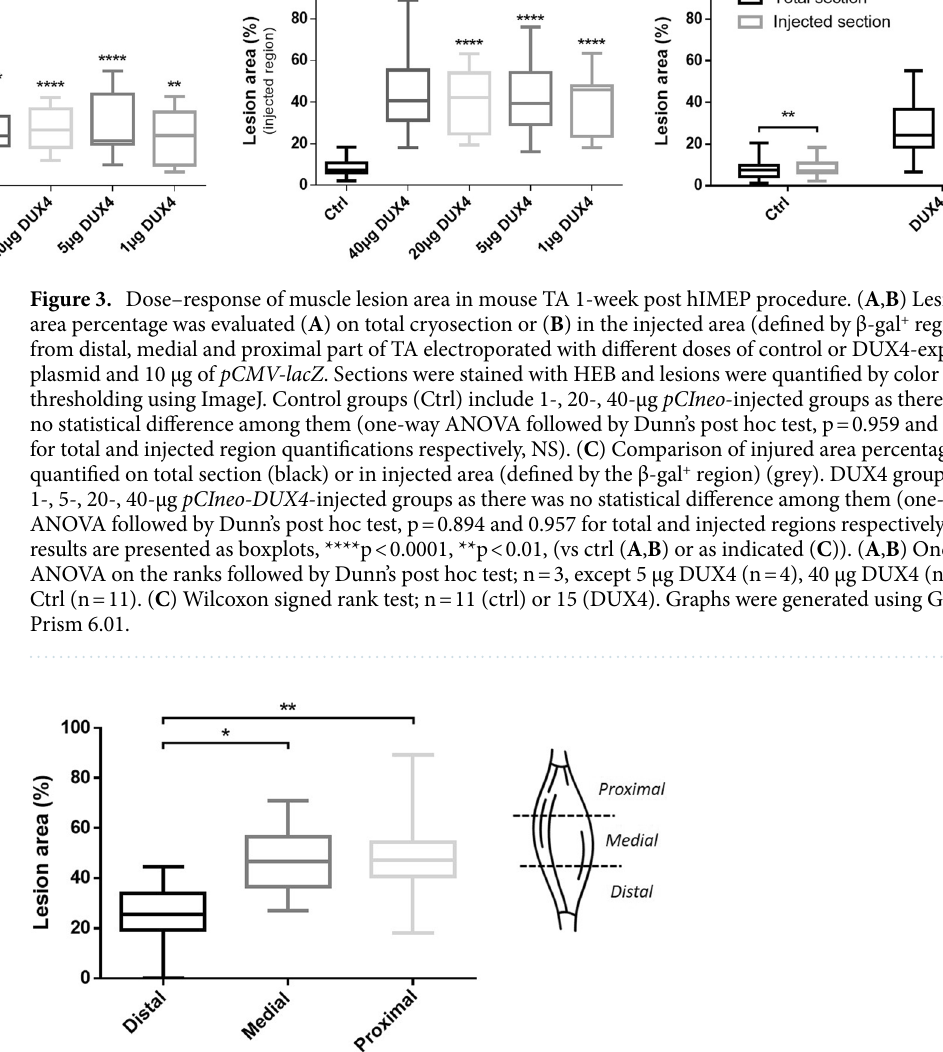
Figure 4. Lesion distribution through TA regions. Mouse TAs were electroporated with different doses of pCIneo-DUX4 (1, 5,10, 20 and 40 µg) and 10 µg of pCMV-lacZ . Muscle damaged area 1 week following TA hIMEP was evaluated in the injected area (β-gal + ) of HEB stained cryosections from distal, medial and proximal regions of TA (color thresholding, ImageJ). Since no statistical difference was observed between tested doses considering each region individually, data were respectively pooled to form single proximal, medial and distal groups (data not shown, One-way Anova, p = 0.871, 0.821 and 0.395 in proximal, medial and distal region respectively). All data are presented as boxplots, *p < 0.05 and **p < 0.01. Friedman Repeated Measures Analysis of Variance on Ranks; n = 15 for each group. Graphs were generated using GraphPad Prism